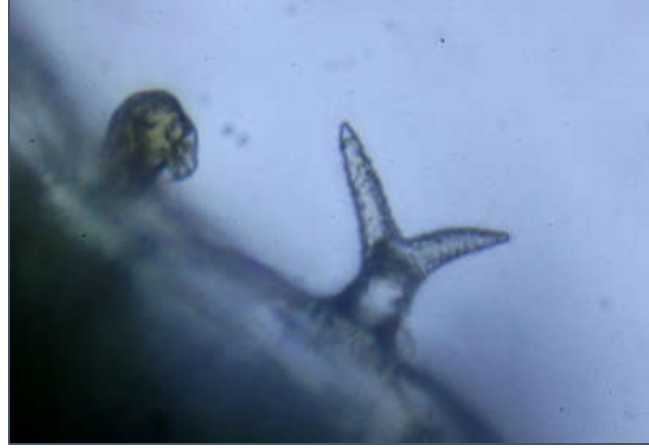
Figure 3. Leaf blade structure in Lavandula intermedia ‘Grappenhall’: secretory trichome (on the left), and covering trichome (on the right). Photos by M.C.-W. and Dr. Miłosz Mazur.